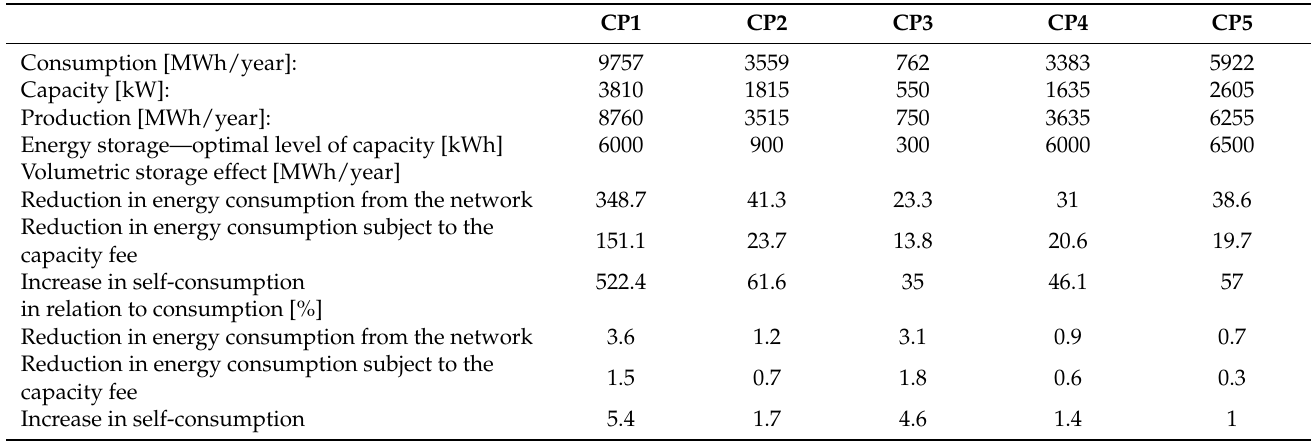
Table 3. Volumetric effects of real energy storage in cooperatives (CP).